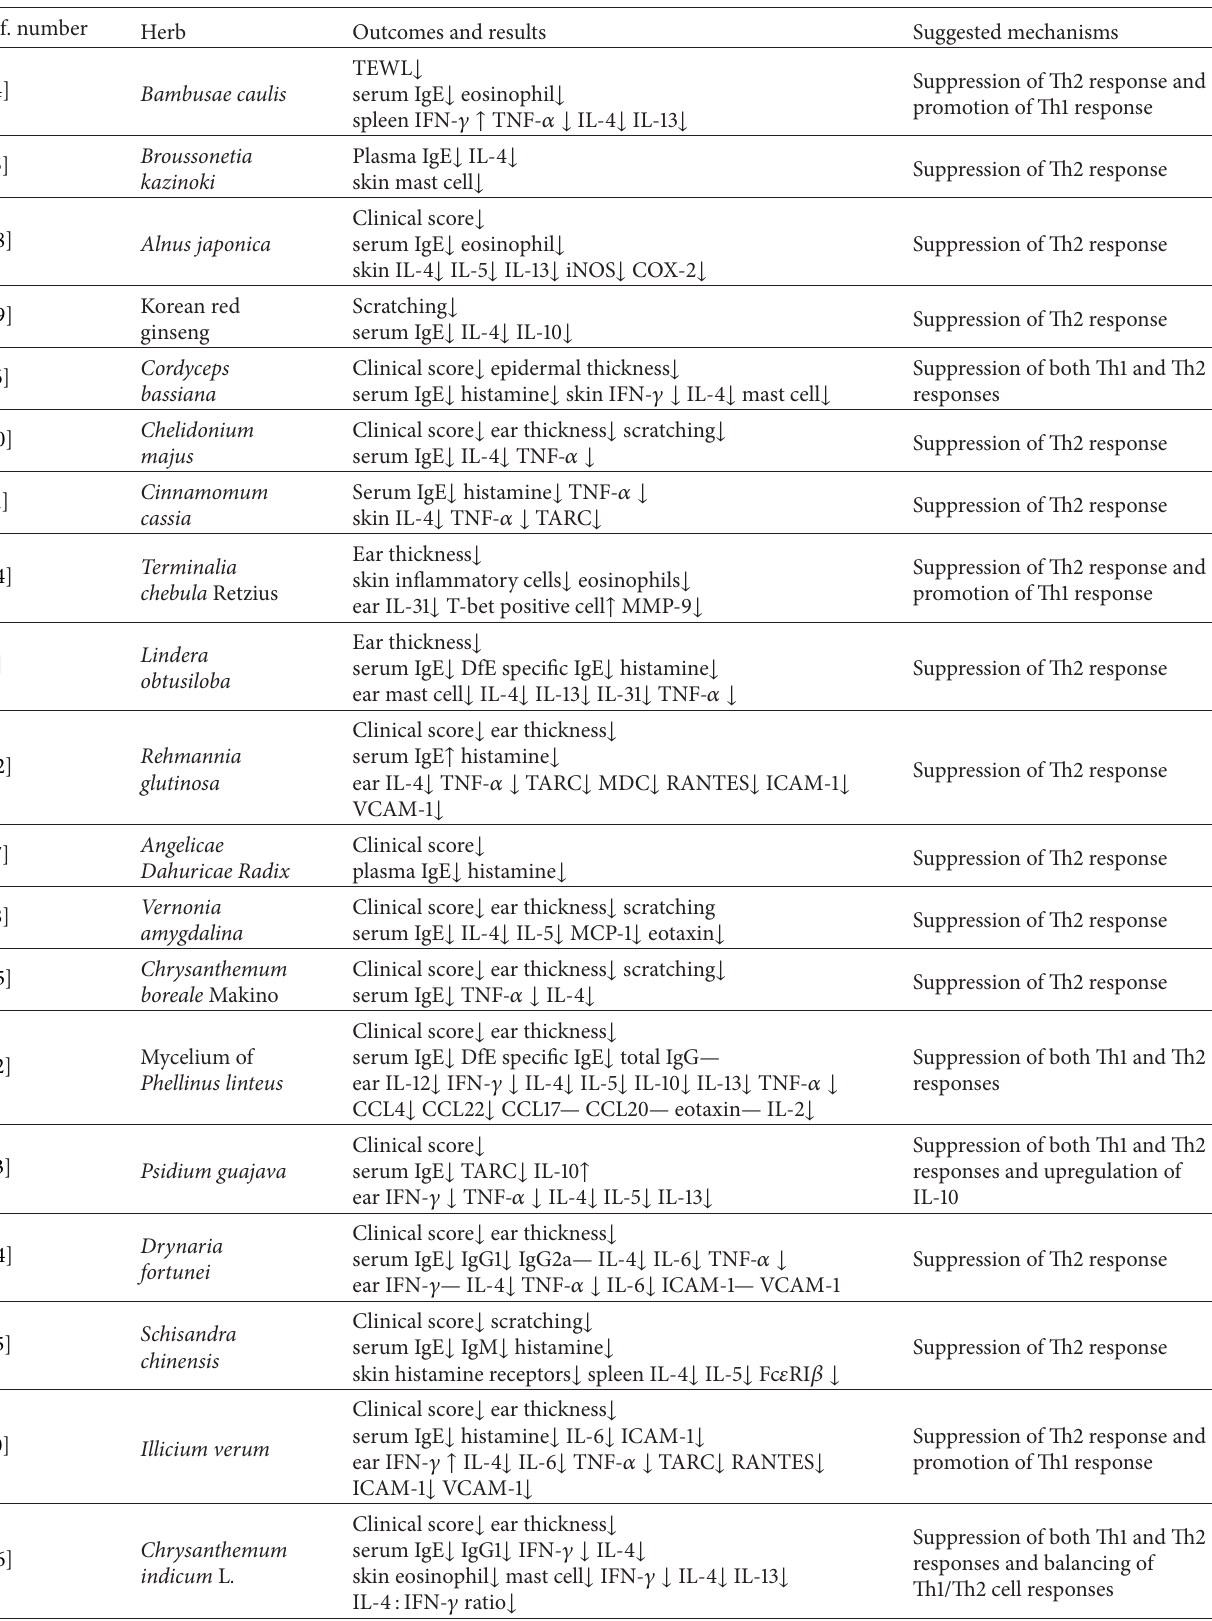
Table 4: Investigated herbs, results, and suggested mechanisms of action in the included studies. Ref.